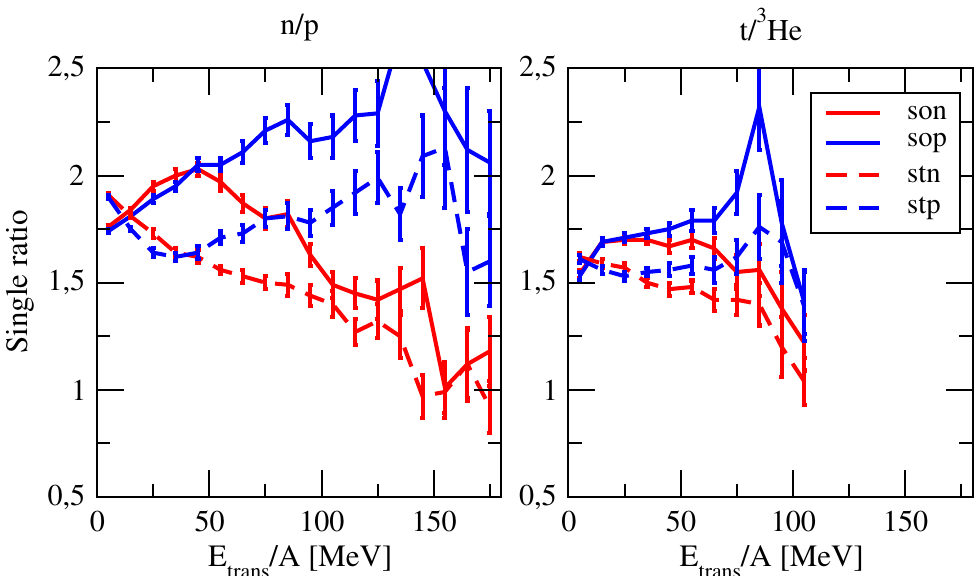
Figure 6. ( Left ) The neutron–proton ratio in 136 Xe + 124 Sn collisions at 150 AMeV for different choices of the symmetry energy and ordering of the effective masses, as indicated in the legend and discussed in the text: solid and dashed lines for stiff and soft symmetry energies, respectively, and red and blue lines for m ∗ n > m ∗ p and m ∗ n < m ∗ p , respectively. Thus the labels son and sop indicate soft symmetry energy with m ∗ n > m ∗ p and m ∗ n < m ∗ p , respectively, and the labels stn and stp are analogous for stiff symmetry energy. (Right) The corresponding tritium over 3 He ratio. Figure taken from